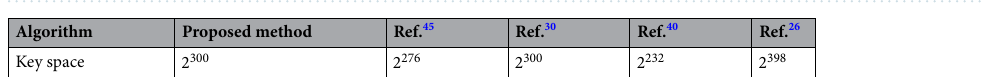
Figure 6. MSE curves concerning the variation of each key: (a) x 01 x 02